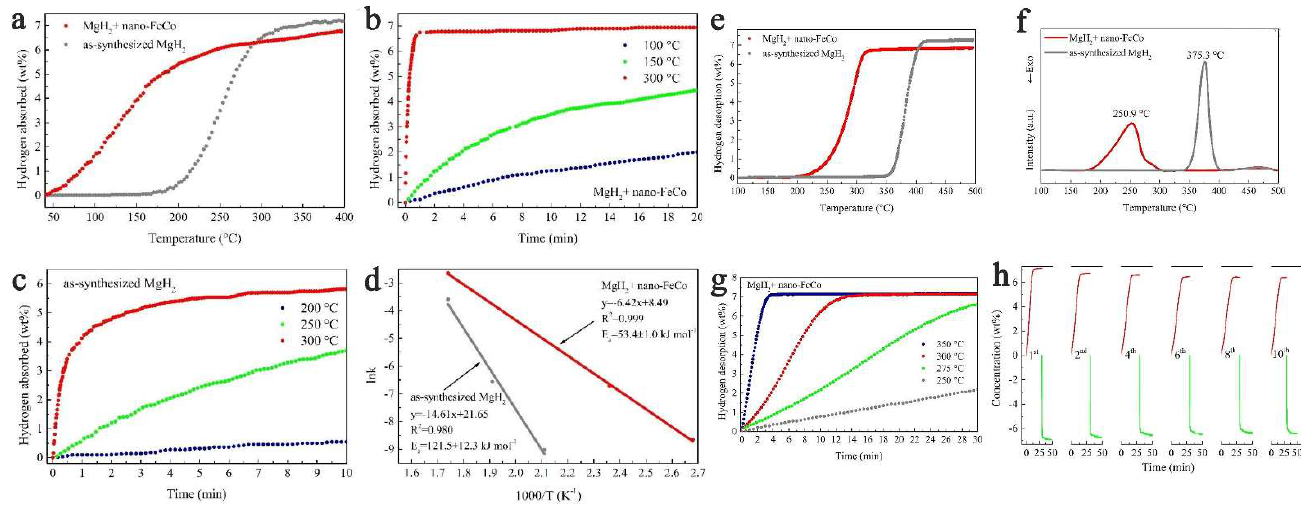
Figure 8. Non-isothermal hydrogenation curves ( a ); isothermal hydrogenation curves at different temperatures ( b , c ) and the corresponding Arrhenius plot of MgH 2 with and without nano-FeCo ( d ); non-isothermal dehydrogenation curves ( e ); DSC curves with a heating rate of 5 ◦ C min − 1 of MgH 2 with and without nano-FeCo ( f ); isothermal dehydrogenation curves of MgH 2 + nano-FeCo composite at 250, 275, 300, 350 ◦ C ( g ); dehydrogenation (in red) and rehydrogenation (in green) curves of MgH 2 + nano-FeCo composite in the 1st, 2nd, 4th, 6th, 8th and 10th cycle ( h ). Reprinted/adapted with permission from Ref. [201]. 2019, Royal Society of Chemistry.